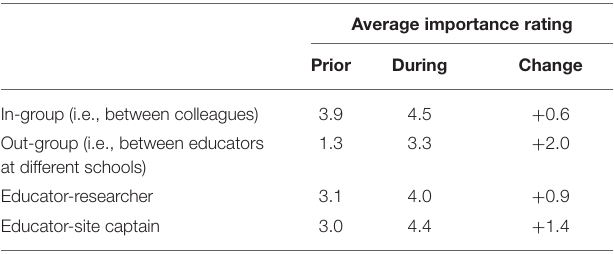
schools, rather than focusing on the differences in their contexts. TABLE 3 | This table shows the average importance rating for different types of